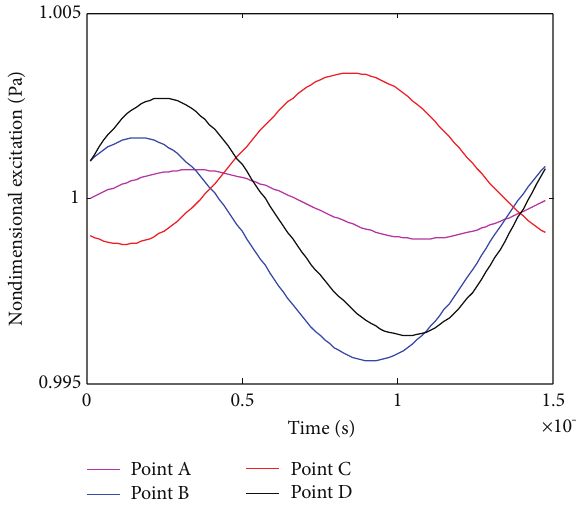
Figure 12: Time history of nondimensional excitation.